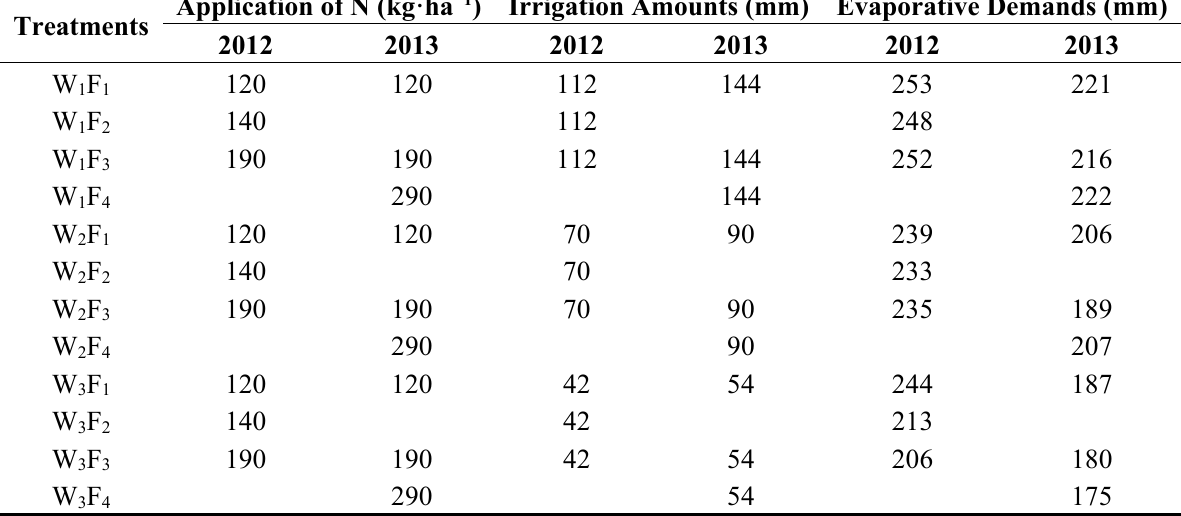
Table 3. Application of N, irrigation amounts and evaporative demands of different treatments for winter wheat cultivation in 2012 and 2013. Application of N (kg·ha − 1 ) Irrigation Amounts (mm) Evaporative Demands (mm) Treatments 2012 2013 2012